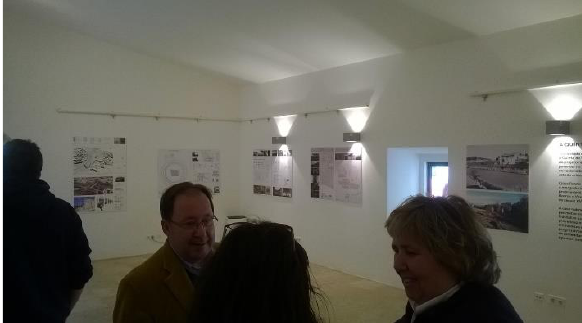
Figure 19. Public exhibition of the student’s work.